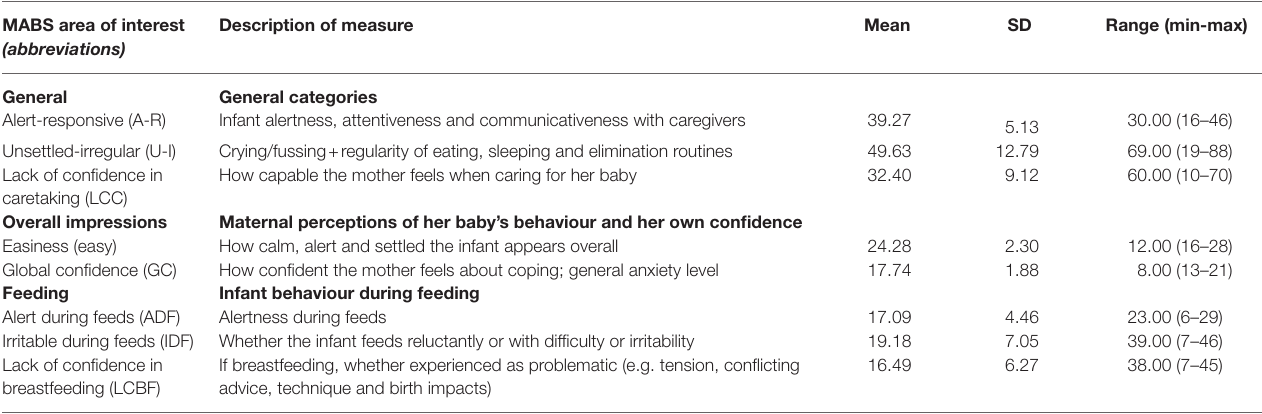
TABLE 1 | Mother and baby scales (MABS) and distribution of